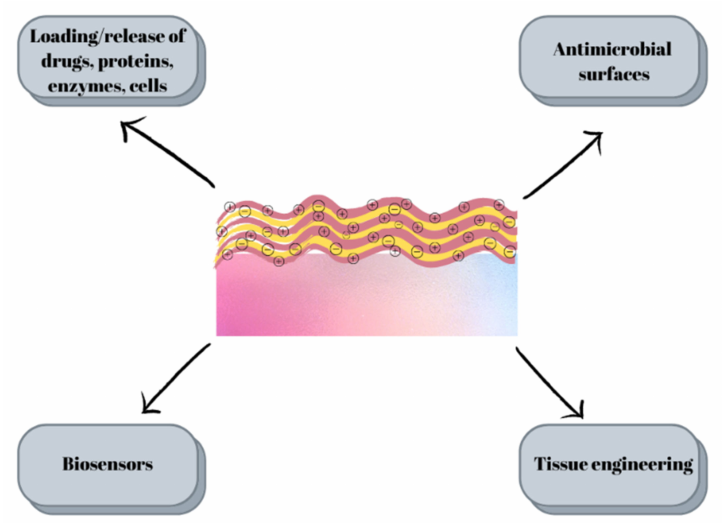
Figure 5. The main biomedical applications of PEMs.